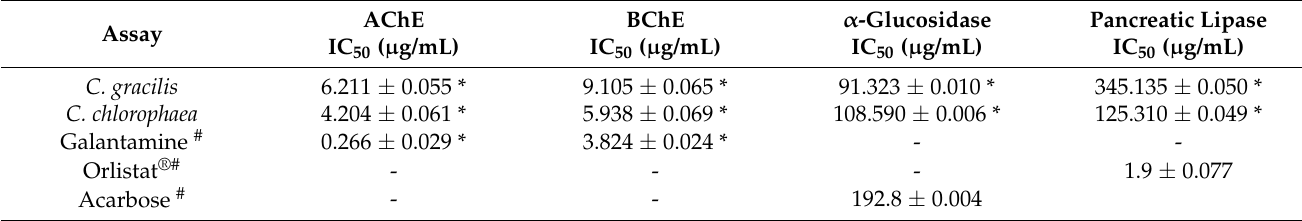
Table 3. Enzyme inhibitory activity of C. gracilis and C. chlorophaea